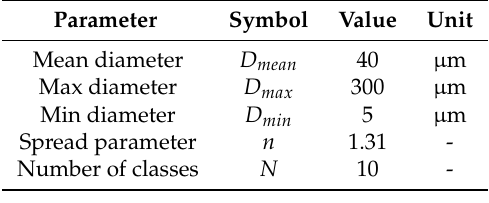
Table 1. Rosin–Rammler distribution parameters.